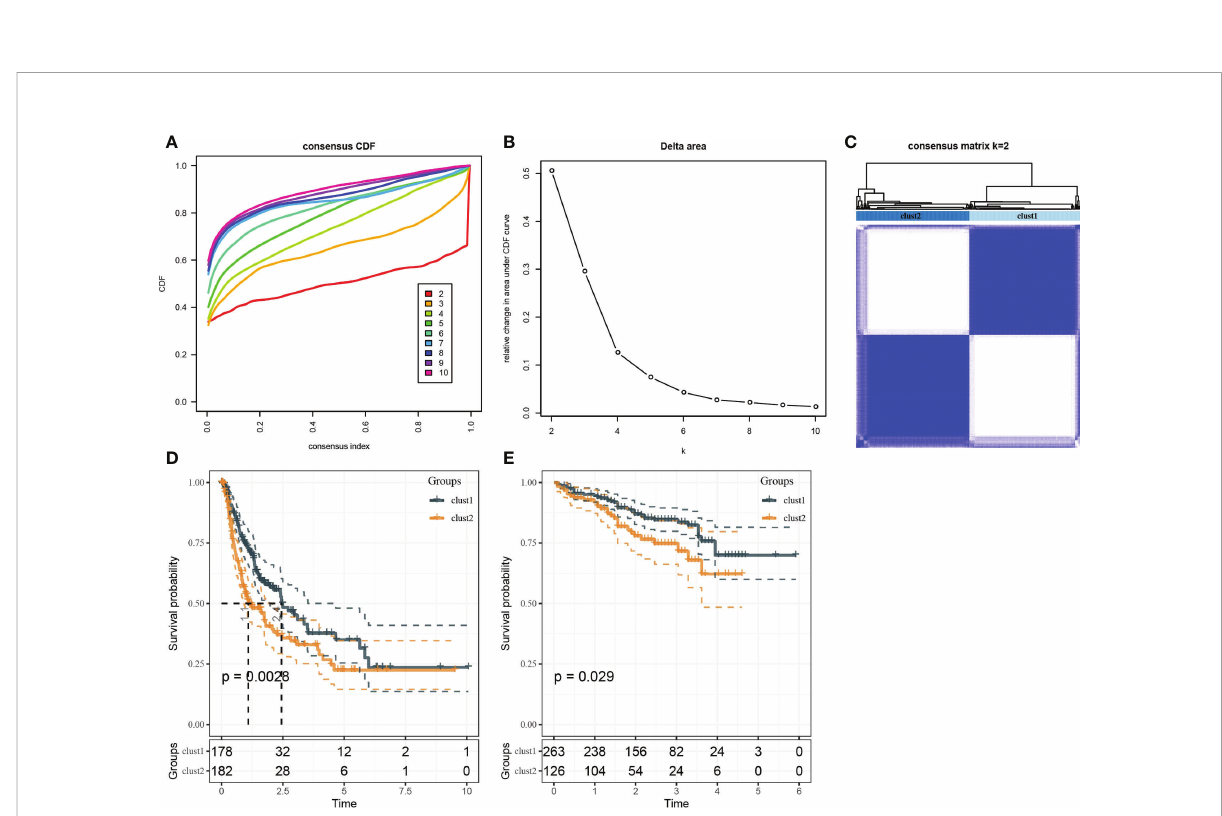
FIGURE 3 Identi fi cation of molecular subtypes. (A) Cumulative distribution function. (B) Delta area. (C) Heatmap of sample clustering when k = 2. (D) K – M survival analysis of Clust1 and Clust2 in TCGA-LIHC dataset. (E) K – M survival analysis of Clust1 and Clust2 in the HCCDB18